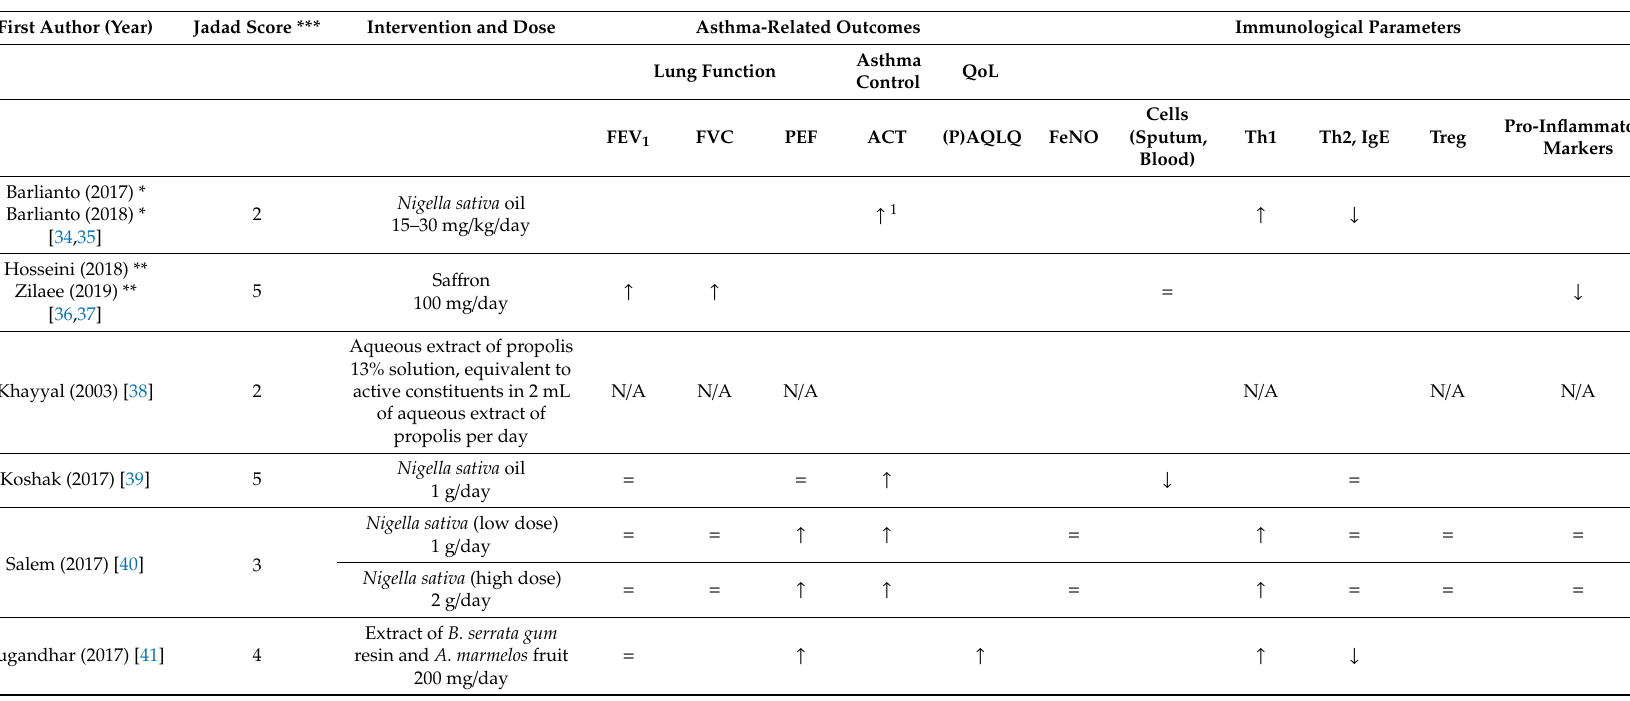
Table 2. Changes in asthma-related outcomes and immunological parameters as compared to the control group for the herbs, herbal mixtures and extracts